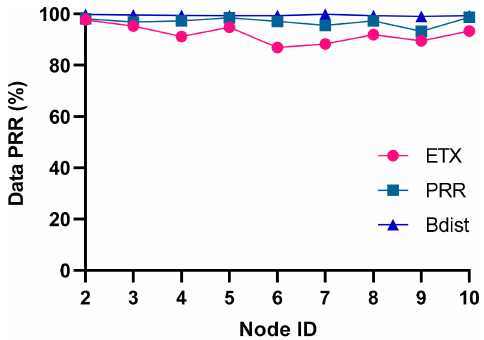
Figure 7. The data PRR of sensor nodes under several estimation